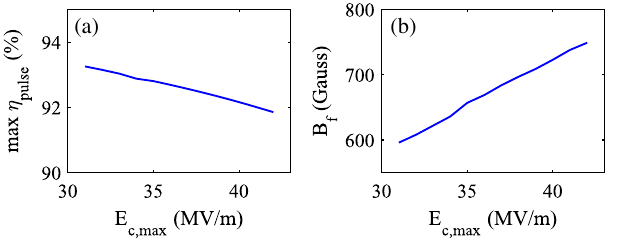
FIG. 9. The maximum η (a) and the corresponding B f (b) as pulse a function of E c; . In this simulation, β is fixed at 179. max